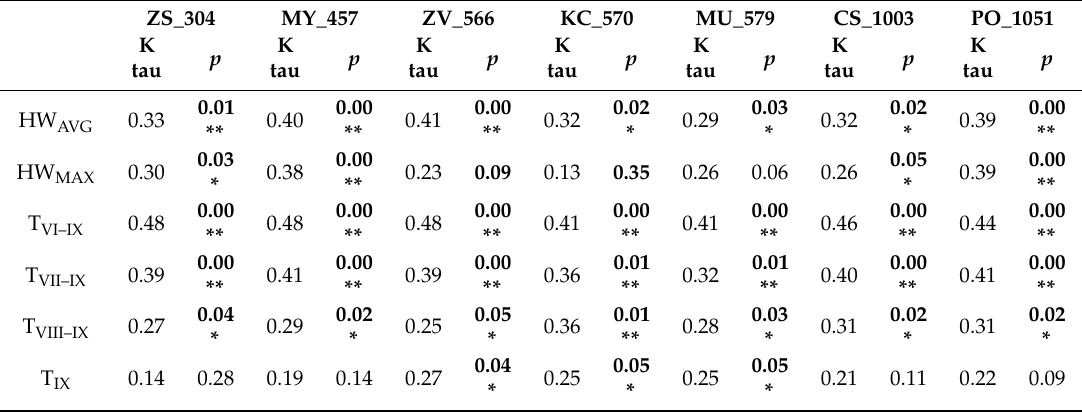
Table 8. Mann–Kendal (M-K) trend test of the heatwaves (HW AVG and HW MAX ) and average temperatures (T VI–IX , T VII–IX , T VIII–IX , and T IX ) prior to onset of leaf colouring during 1989–2018. Significant trends with p ≤ 0.1 (**) and p ≤ 0.5 (*) are highlighted with bold.